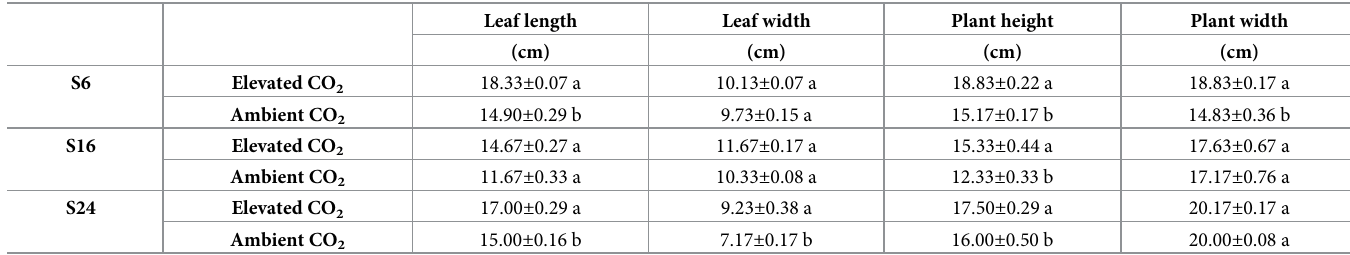
Table 1. Effect of elevated CO 2 on the growth of lettuce.